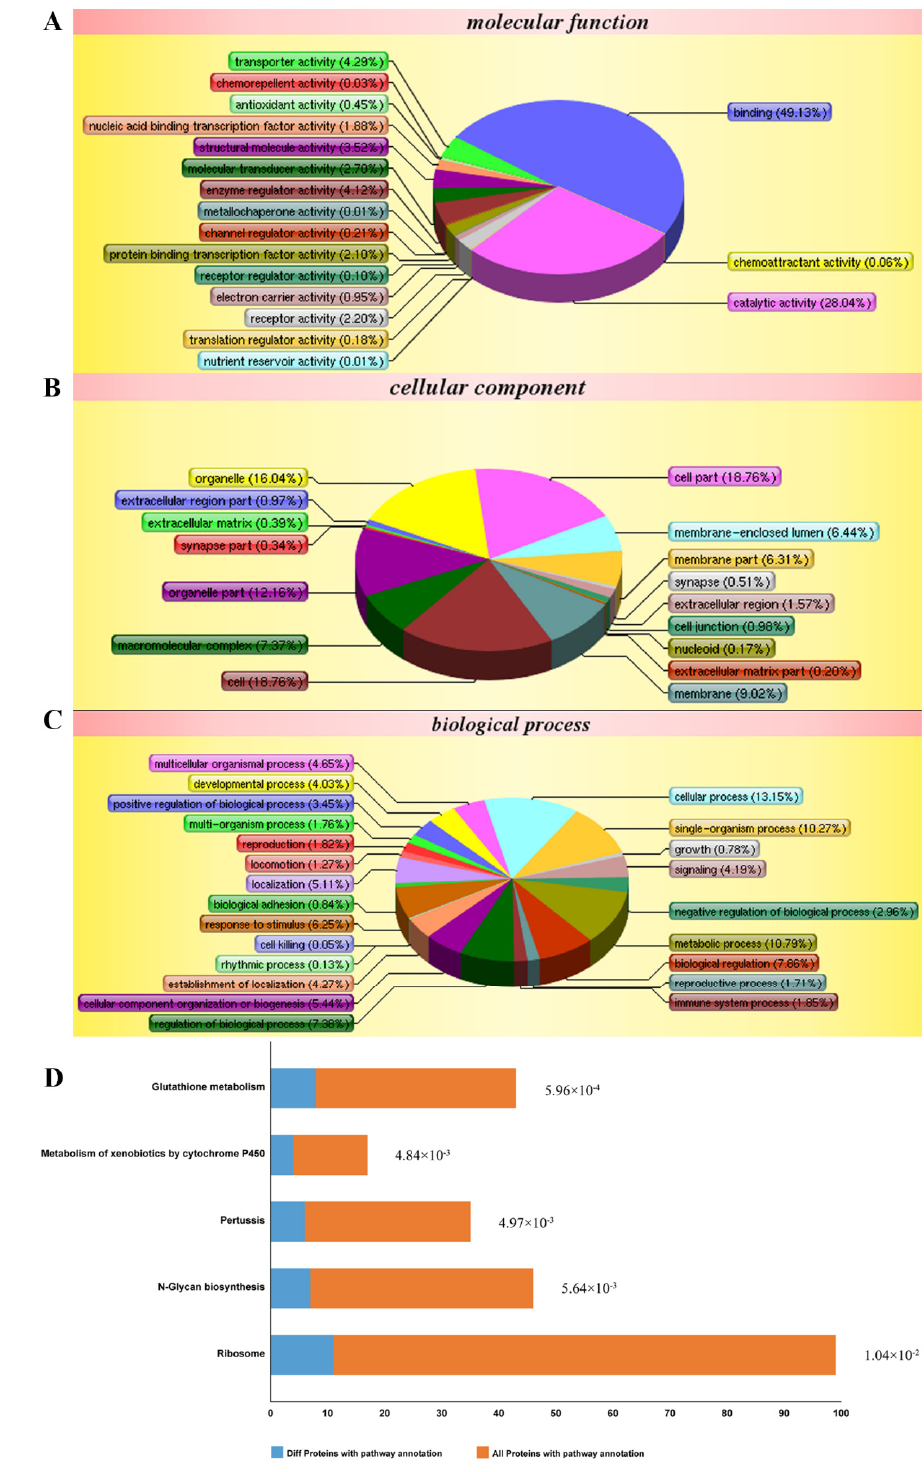
Figure 3. Differentially expressed proteins impacted by LPS and TDD treatment compared to LPS treatment in EA.hy926 cells were analyzed according to gene ontology in three dimensions and KEGG pathways: ( A ) biological processes, ( B ) cellular localization, ( C ) the molecular functions, and ( D ) KEGG pathways. EA.hy926 cells were treated with TDD (10 µ M) for 4 h, and then LPS (1 µ g/mL) was added for 12